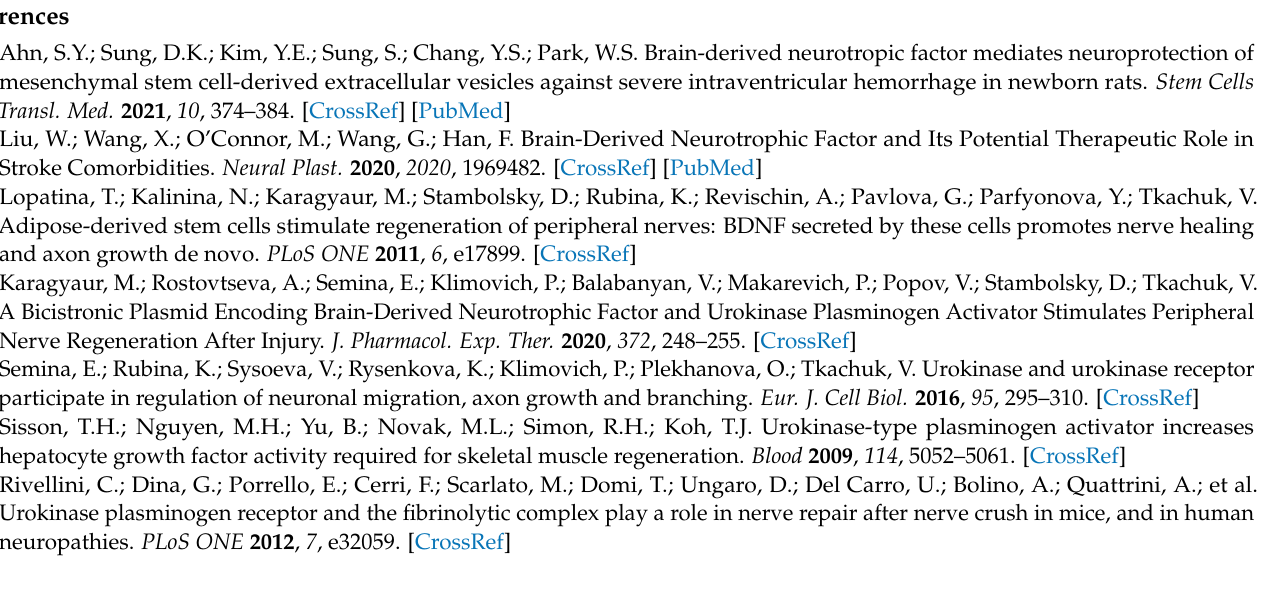
Figure S3: Samples of images (raw data) obtained during the study of neuroprotective activity of BDNF, uPA and BU medium samples in the model of in vitro glutamate-mediated excitotoxicity. Green stain marks dead cells (apoptosis); Figure S4: Brain-derived neurotrophic factor